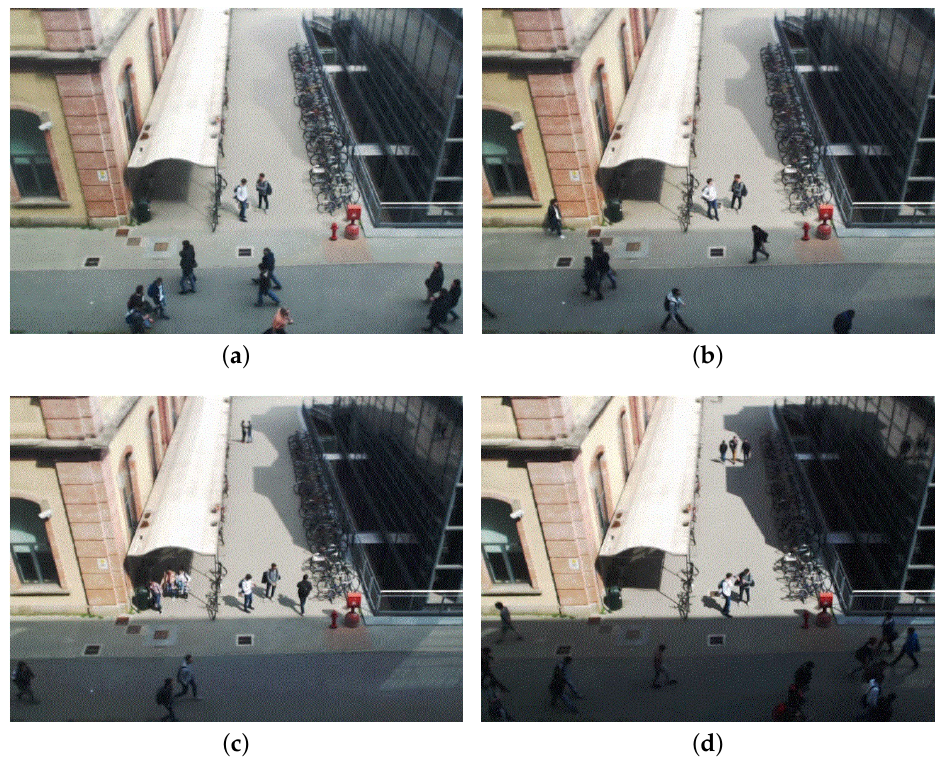
Figure 13. Working conditions with abrupt weather change: From dim ( a ), to sunrise ( b ), bright ( c ). and heat ( d